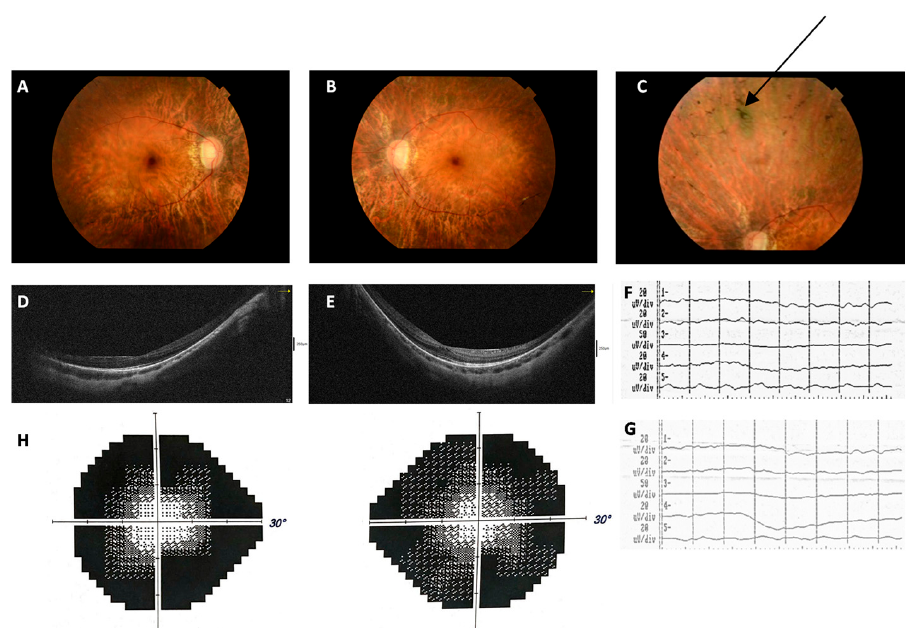
Figure 1. Clinical features of patient S15 with RP. Fundus photography of the right eye ( A ) and left eye ( B ), showing typical features of RP including optic disc pallor, attenuated retinal vessels, and mid-peripheral bone-spicule pigmentation (indicated by an arrow) ( C ). ( D , E ) Optical coherence tomography (OCT) showed thinning of the retina and loss of photoreceptors out of the fovea. In the RE visible single cystic changes in the foveola and fine epiretinal membrane in the temporal part of the macula. ( F,G ) Full-field electroretinogram (ERG) demonstrated residual rod and cone response amplitude. (H) Concentric narrowing (to approx. 10°) of the visual field of both eyes.